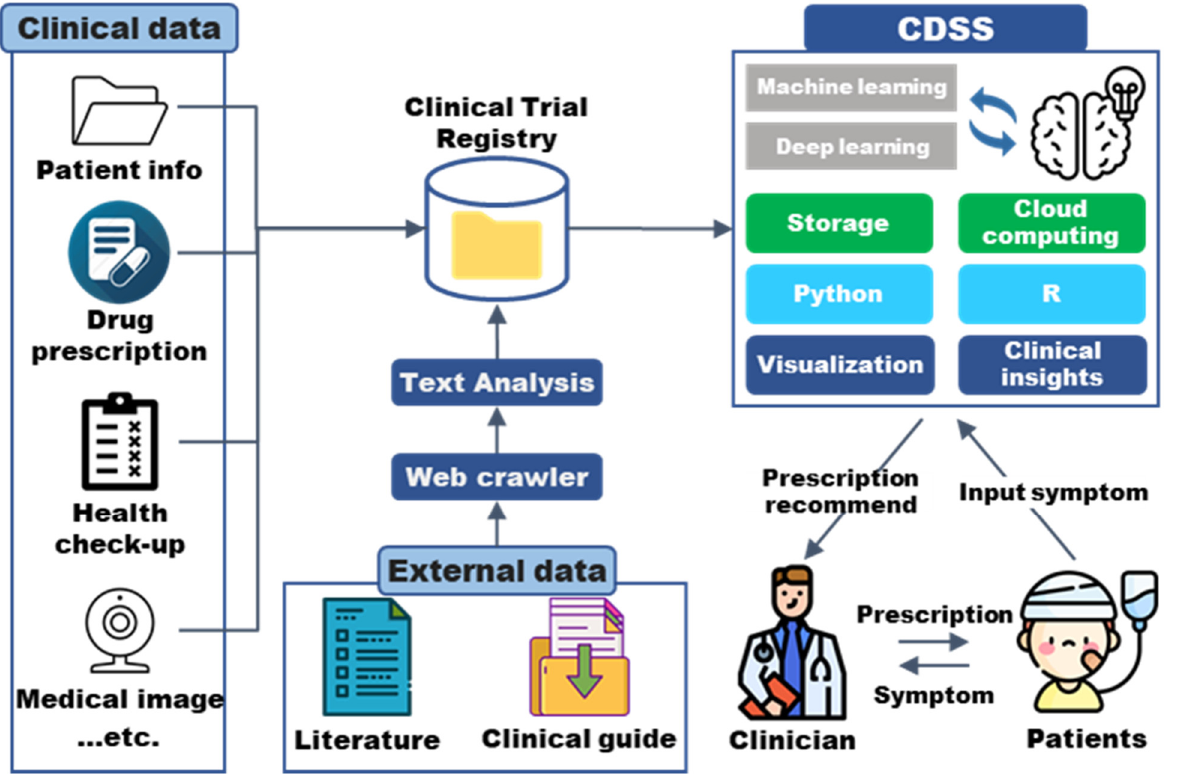
Figure 3. Integrated strategies of the clinical decision support system (CDSS). Clinical data consist of patient information, drug prescription, data from health check-ups, and medical images. These data should be cleaned and indexed in a format commonly used in the field. In addition, as external data, scientific papers and clinical guidelines can be deposited in storage or cloud computing systems using web crawler or text mining tools. Machine learning can be used as an algorithm for CDSS; the languages mainly used are Python and R. Machine learning aims to visualize this appropriately and provide patient-specific clinical insights to clinicians. Using the CDSS developed as the model, researchers can obtain clues to the development of a genomic information management system (GIMS).